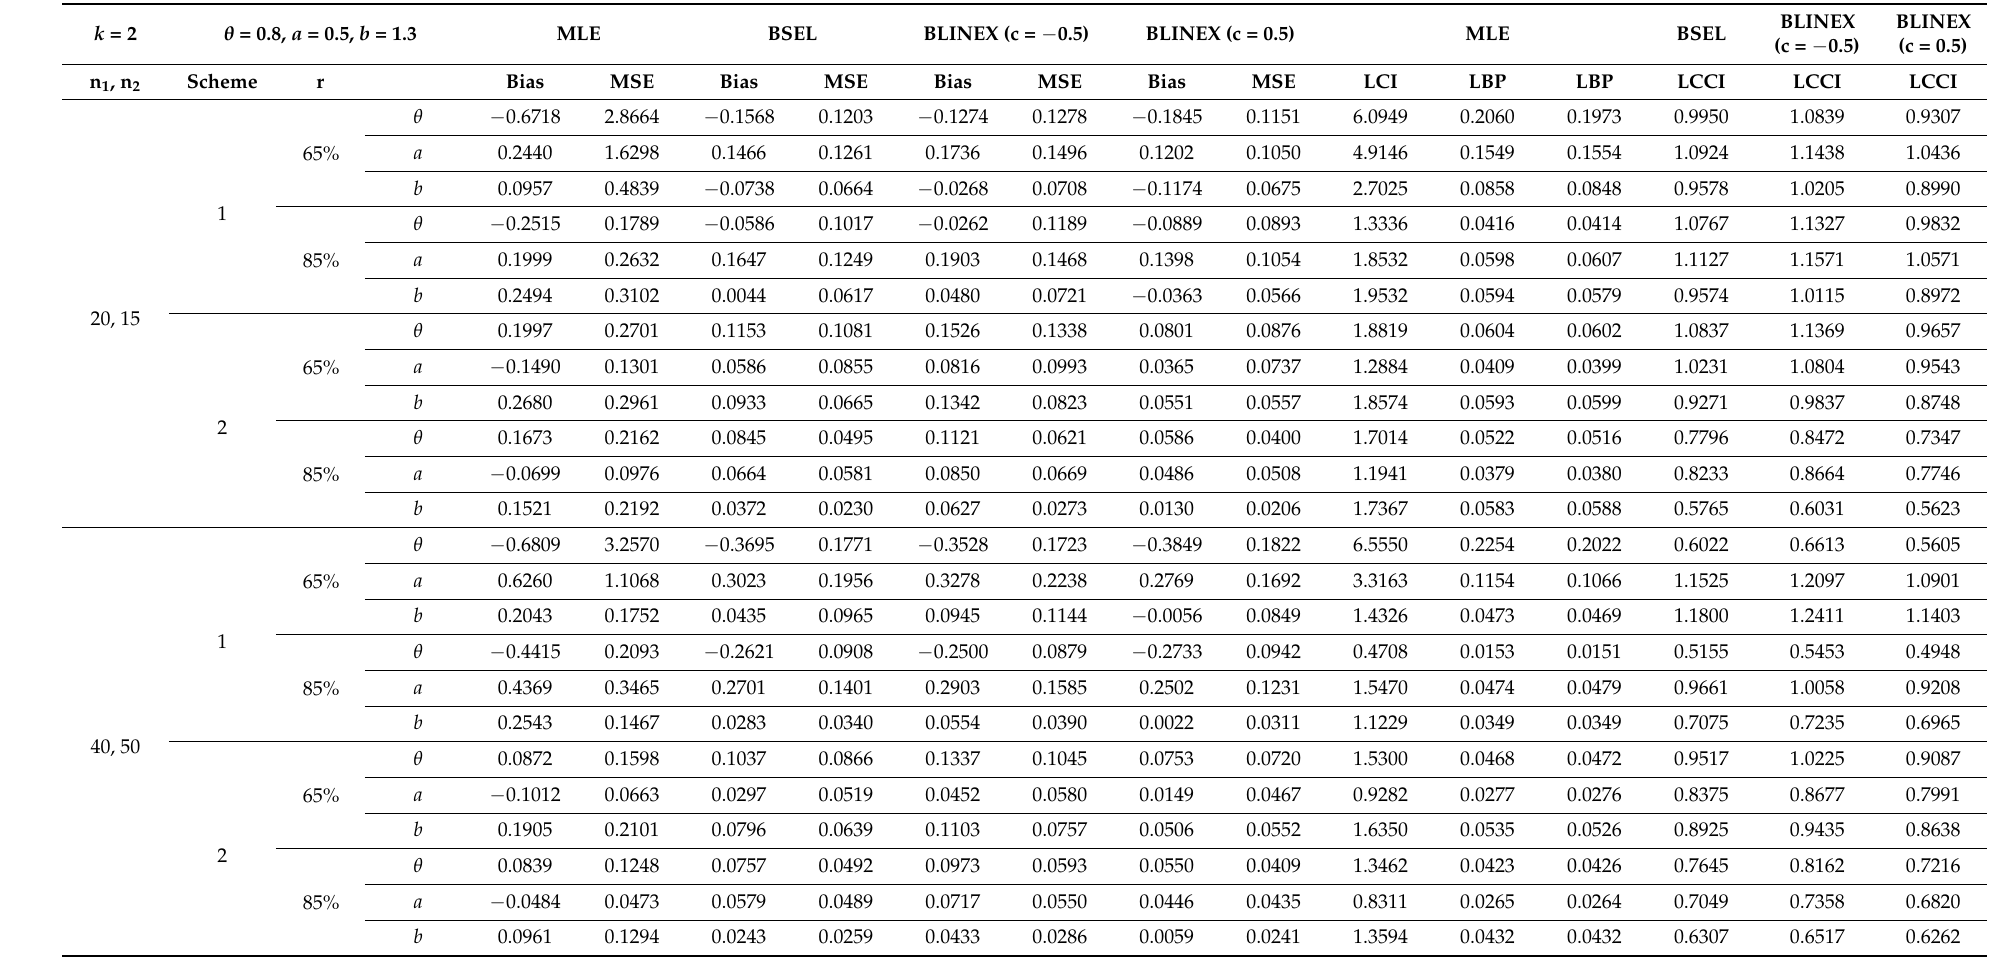
Table 2. MLE and Bayesian estimation with different loss functions in the simple ramp when θ = 0.8, a = 0.5, b =